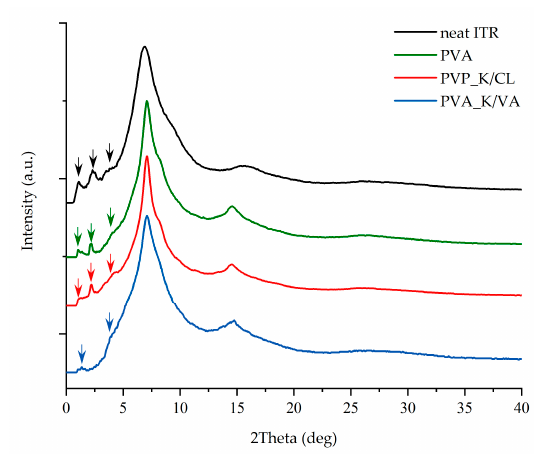
Figure 4. XRD diffraction patterns of neat ITR and its mixtures with PVA, PVA_K/VA, and PVA_K/CL Figure 4. XRD di ff raction patterns of neat ITR and its mixtures with PVA, PVA_K / VA, and PVA_K / CL in an initial form of 3DP tablet. in an initial form of 3DP tablet.